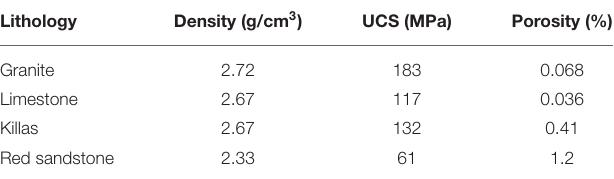
TABLE 1 | Basic rock parameters.